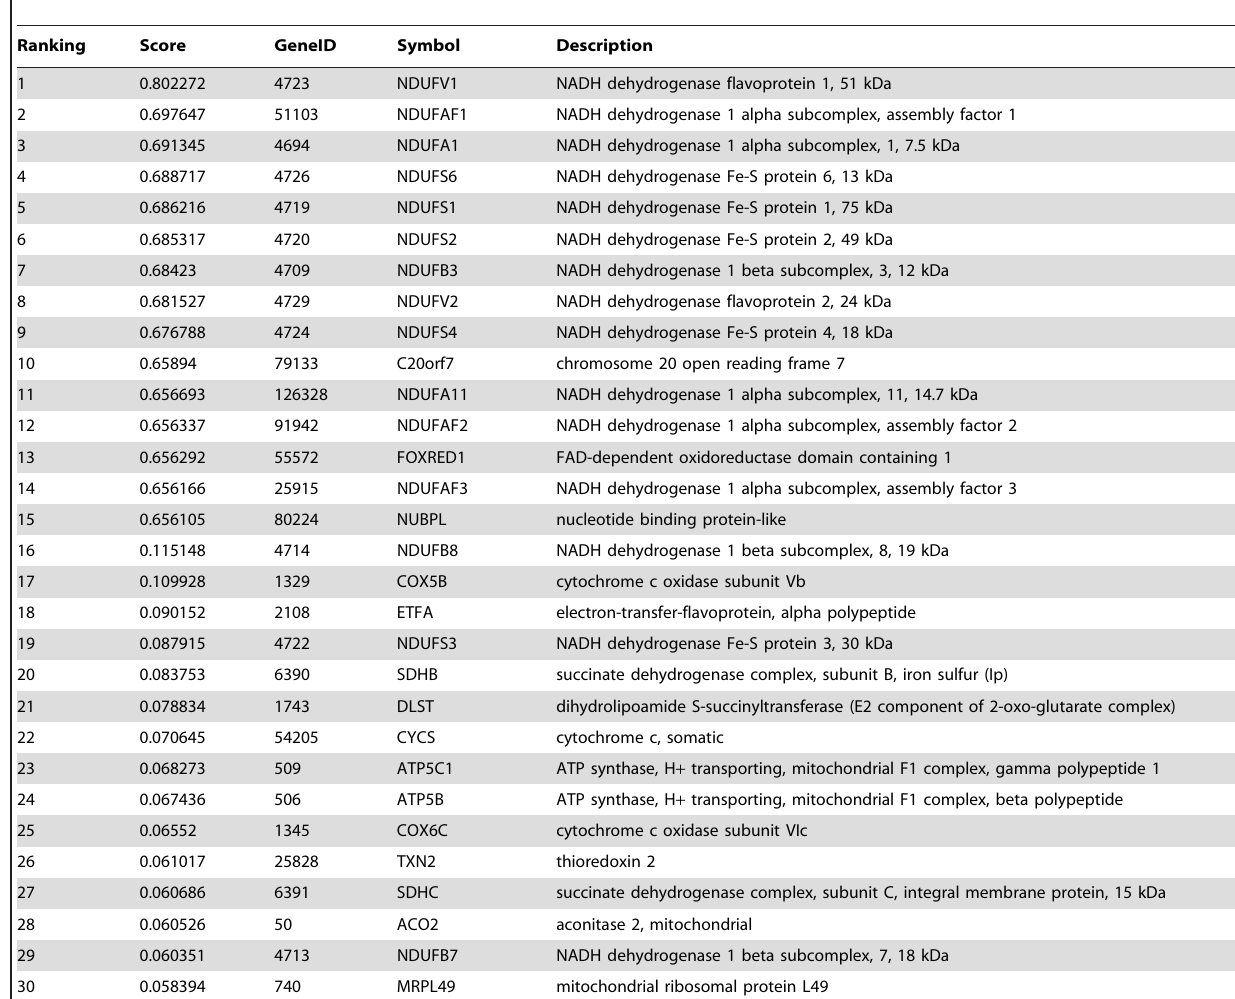
Table 5. The 30 top-ranking genes for mitochondrial complex I